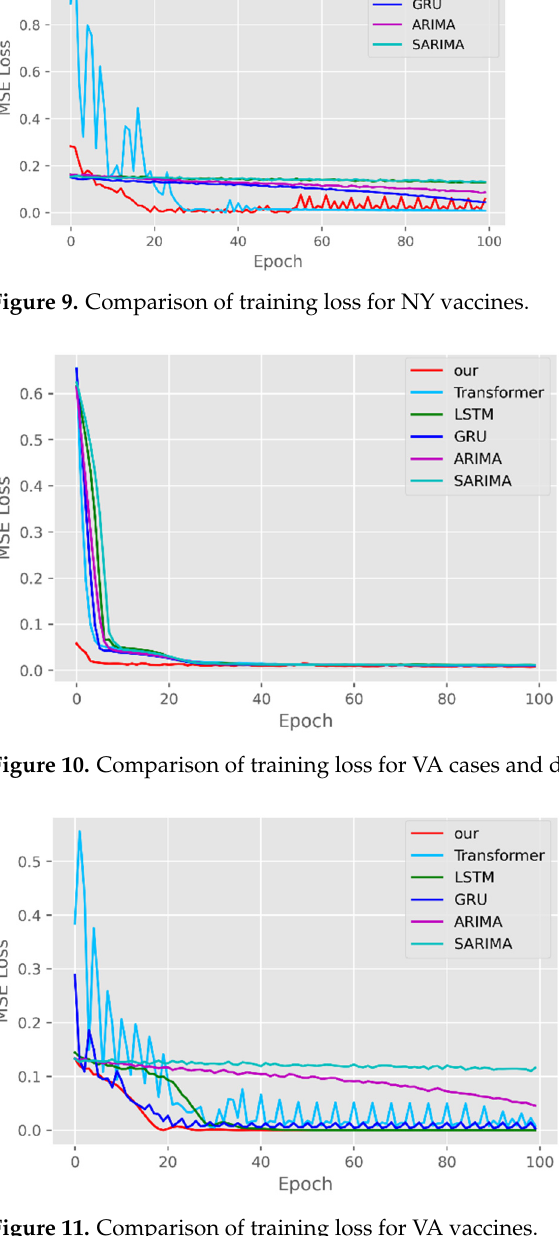
Figure 11. Comparison of training loss for VA vaccines.